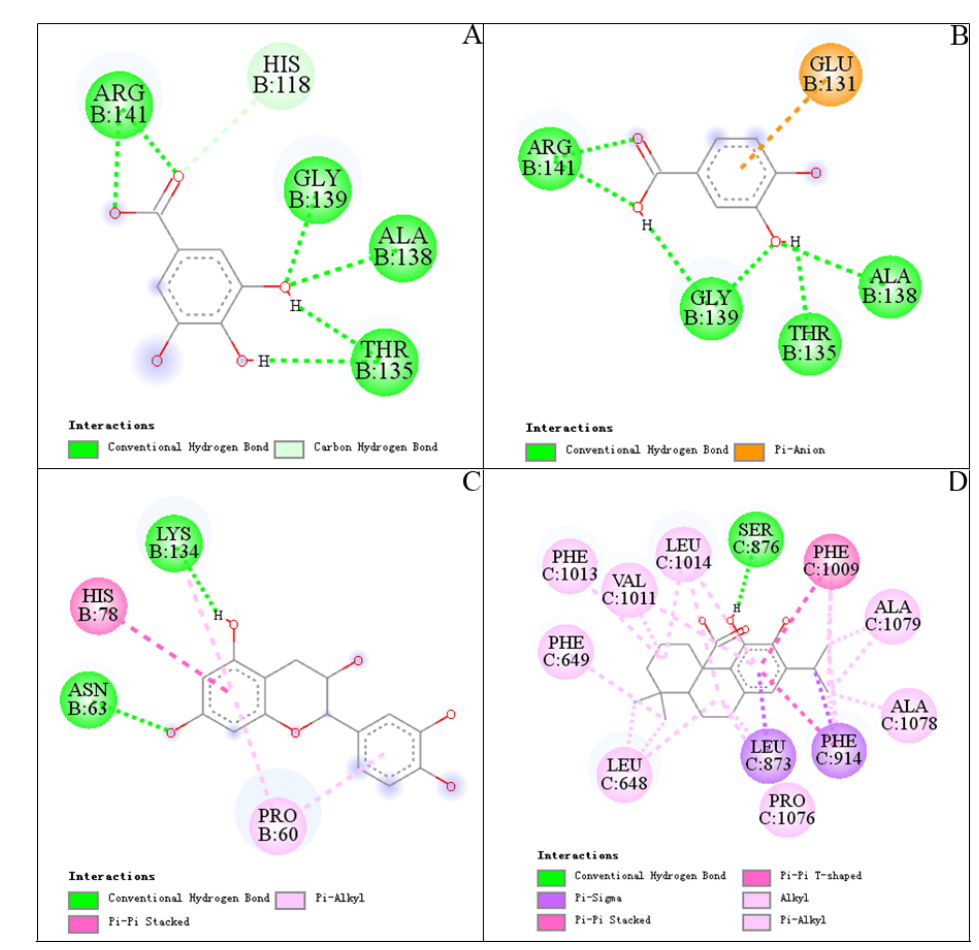
Figure 5 . Docked complexes of SOD and XOD with peak 1 (gallic acid), peak 3 (protocatechuic acid), peak 9 (( − )-epicatechin) and peak 15 (carnosic acid) from A. indica : ( A ), SOD-gallic acid; ( B ), SOD-protocatechuic acid; ( C ), SOD-( − )-epicatechin; ( D ), XOD-carnosic acid. Blue lines represent hydrogen bonds.